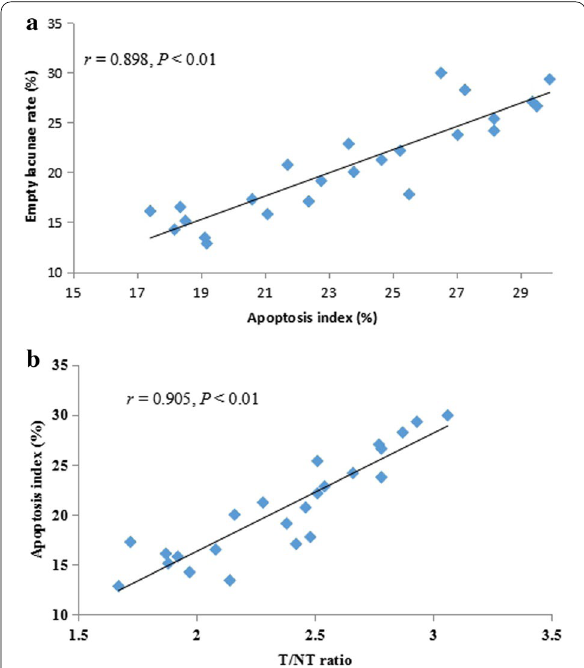
Fig. 6 Pearson correlation analysis. Positive correlation between the empty lacunae rate and the apoptosis index ( a ), positive correlation analysis between the apoptosis index and the T/NT ratio ( b ). T/NT, target tissue and non-target